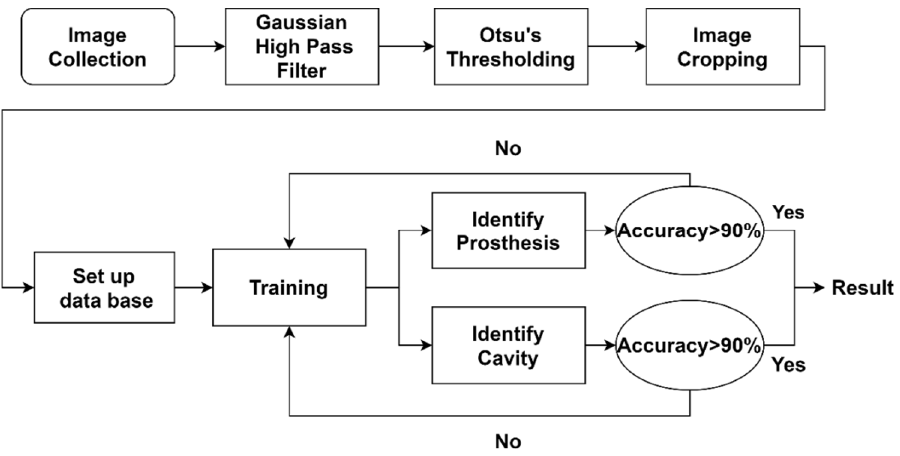
Figure 1. Flowchart of the proposed method.